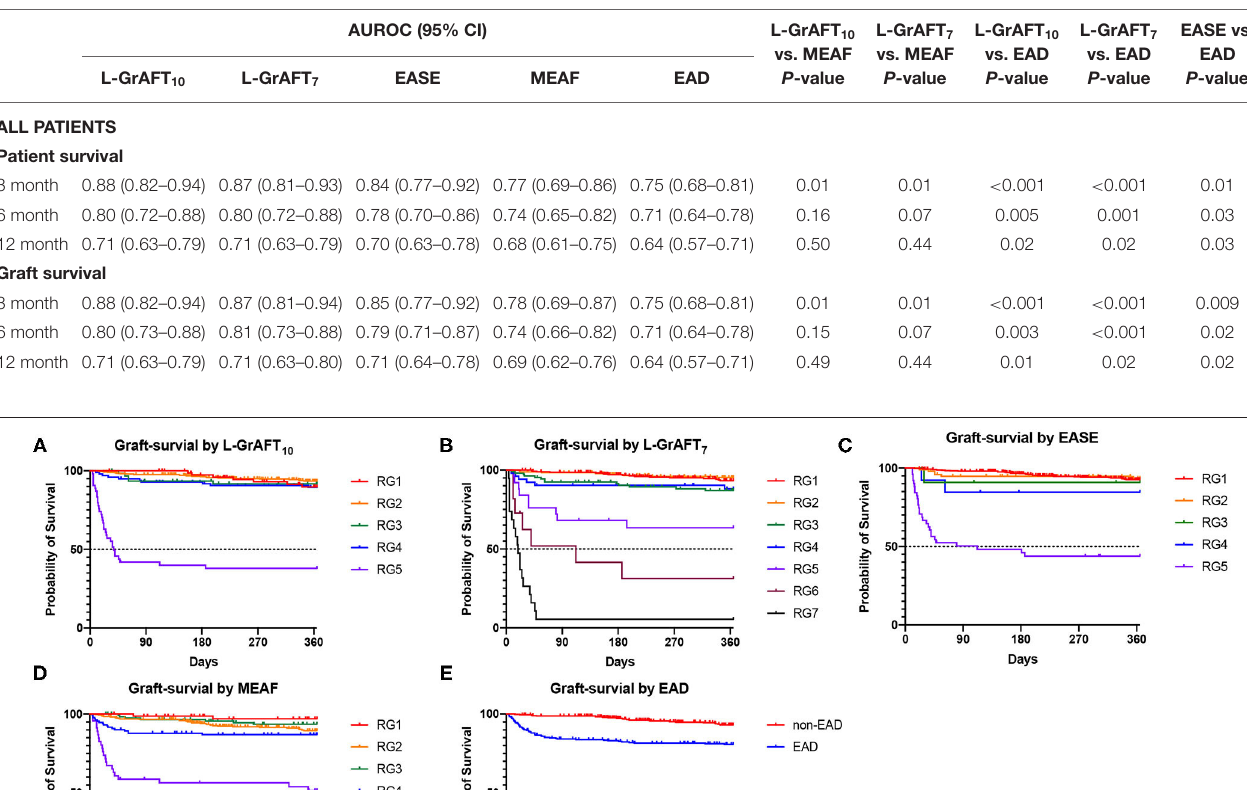
TABLE 1 | Validation AUROC and comparison among L-GrAFT 10 , L-GrAFT 7 , EASE, MEAF, and EAD.